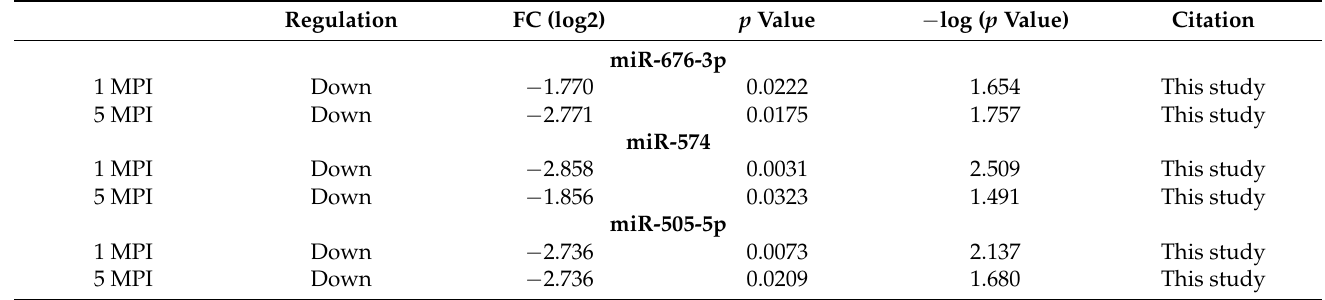
Table 6. Longitudinal regulation of EC-associated miRNAs by THC in virally suppressed